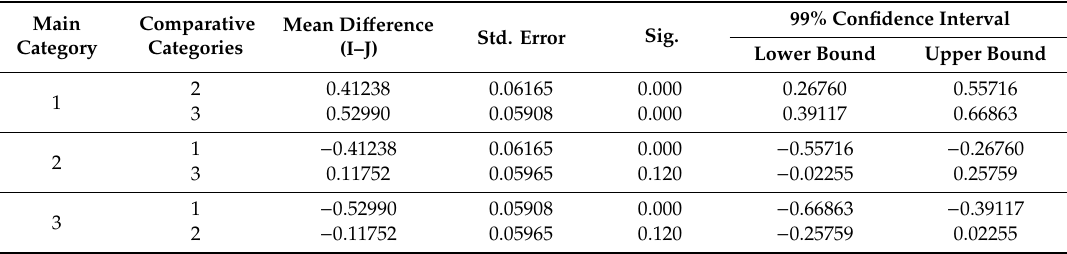
Table 3. Results obtained from the Games–Howell post-hoc